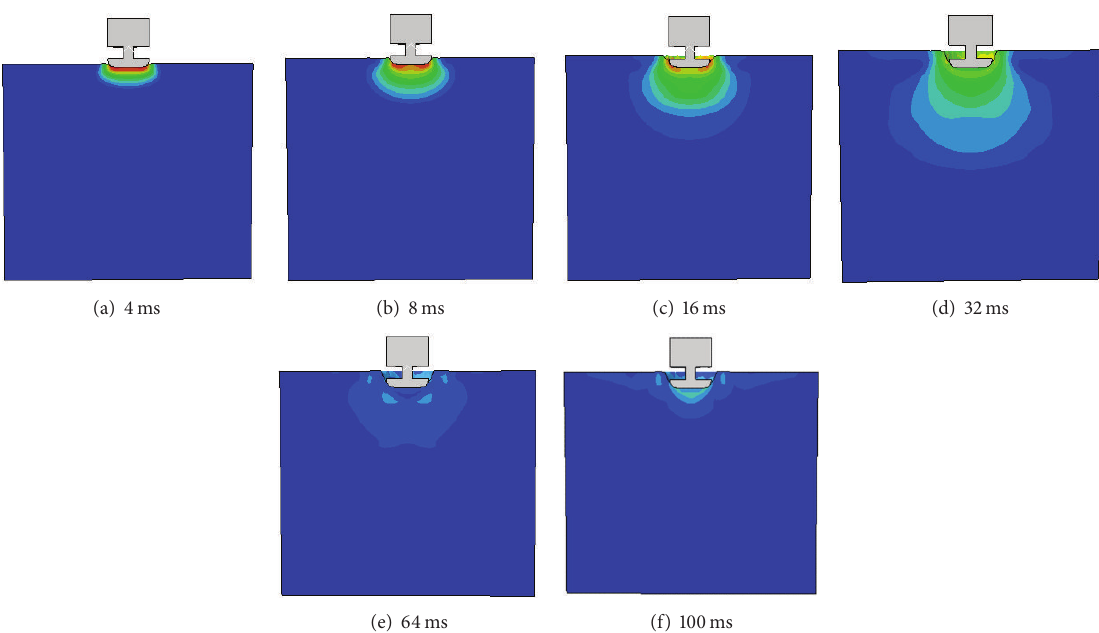
Figure 27: Mises stress distribution when 𝐷 𝑟 = 60 %, V = 4 m/s, and 𝑚 = 3